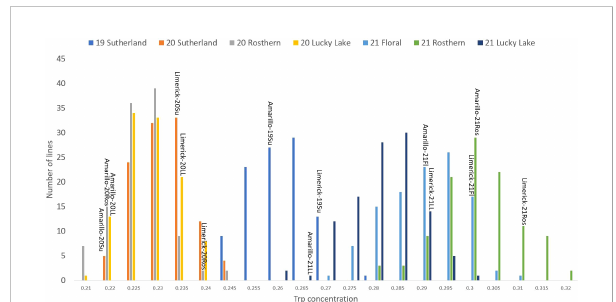
FIGURE 4 Frequency distribution of tryptophan concentration of PR-25 across seven station-years based on the average of biological replicates for each line in each station-year (two biological replicates in 2019 Sutherland and three biological replicates for the rest of the station- years), and the averaged tryptophan concentration for the parents of PR-25 in each station-year.